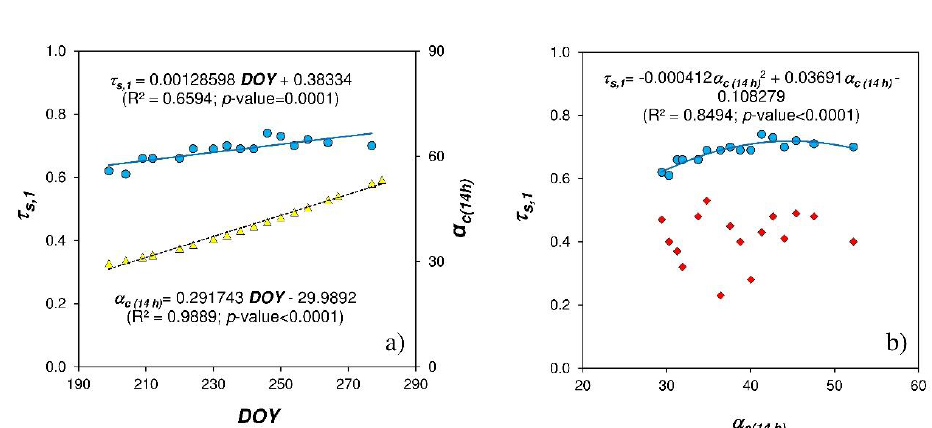
Figure 5. Evolution of the transmissivity τ s , 1 ( • ) of the cover greenhouse without whitening between 12:00 and 16:00 and of the angle of incidence of solar radiation c(14 h) ( (cid:78) ) for the northern slope at 14:00 h according to the day of the year DOY ( a ). Relationship between transmissivity of the cover without whitening τ s , 1 ( • ) and with the different ASP tested τ s , 2 ( (cid:7) ) in function of the angle of incidence c(14 h) of solar radiation. Regression curves for cover transmissivity ( ▬ ) and angle of incidence (---) ( b ).